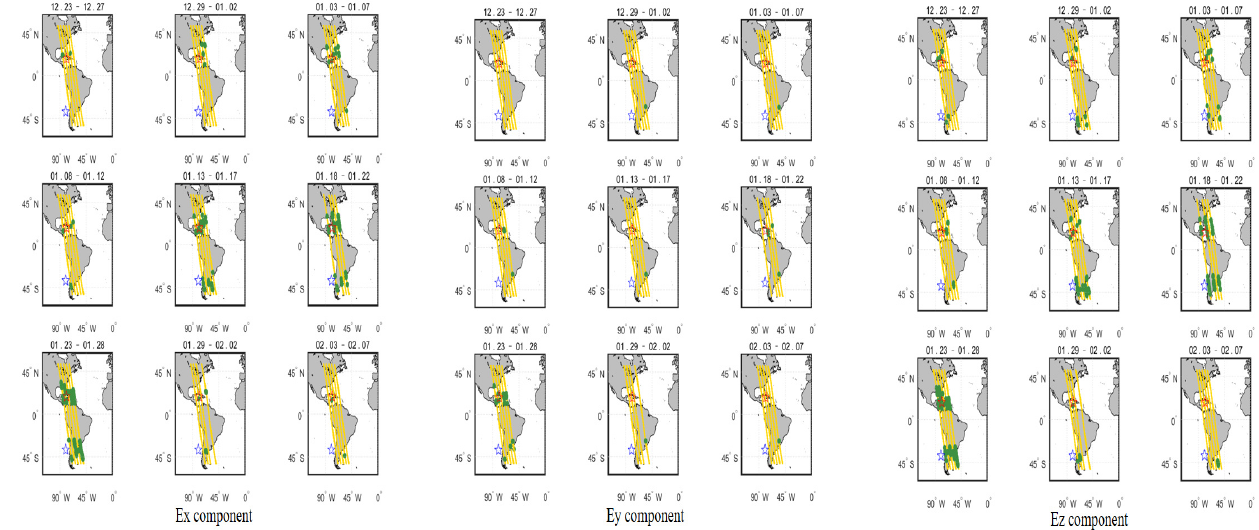
Figure 12. The time-space evolution of the orbit.